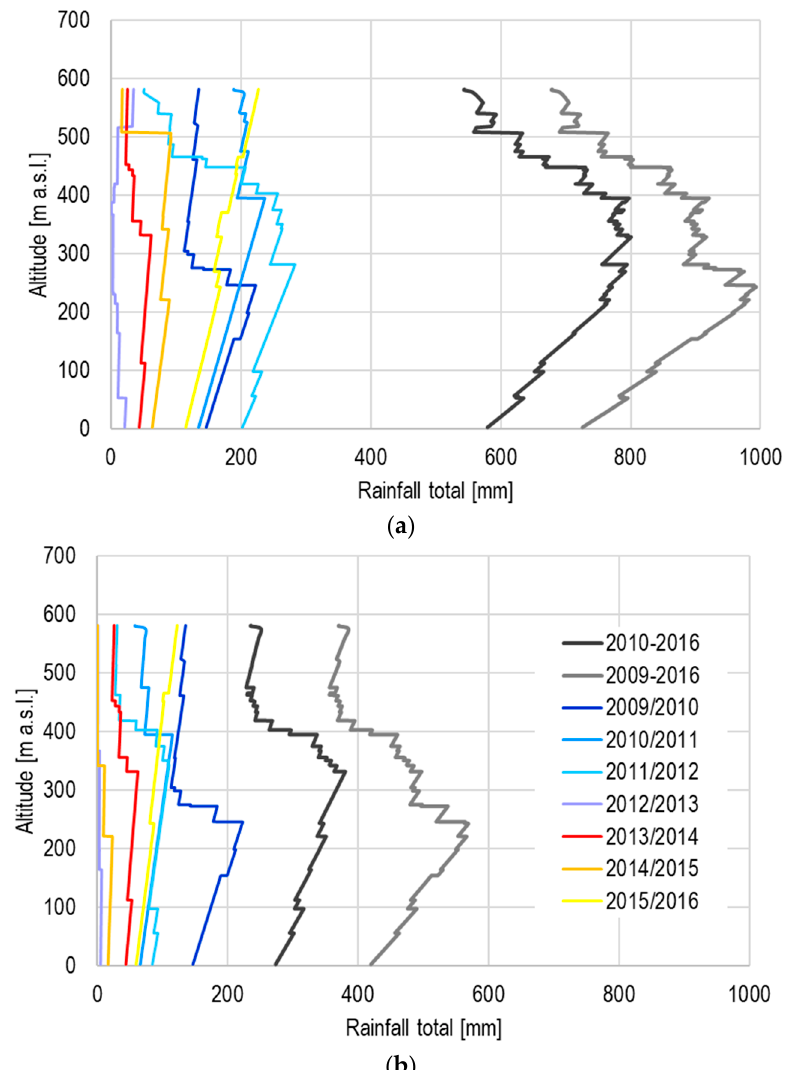
Figure 7. Changes in estimated seasonal (Oct–May) winter rain totals (mm) on Hansbreen: ( a ) all winter rainfall between October and May; and ( b ) winter rainfall occurring following snow accumulation.